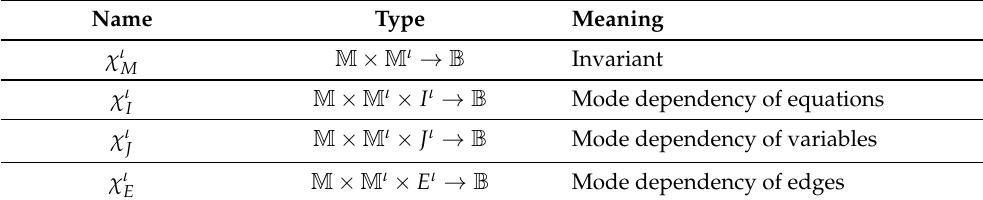
Table 2. Functions generated from parsing the